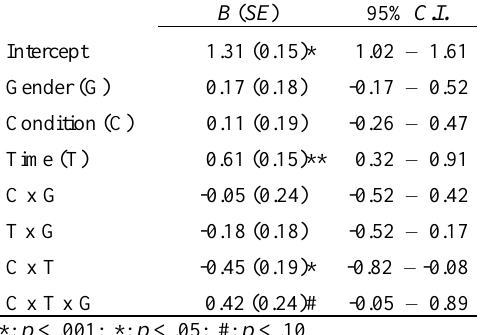
Table 1. Anticipatory stress and negative affect